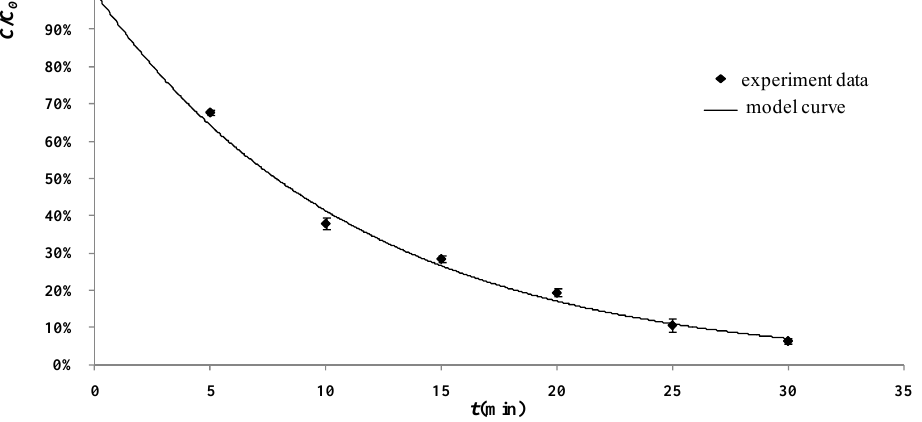
Figure 9. Values from the model developed in this study and from the actual experiments (reaction conditions: air pumped in at 3 mL/s, C